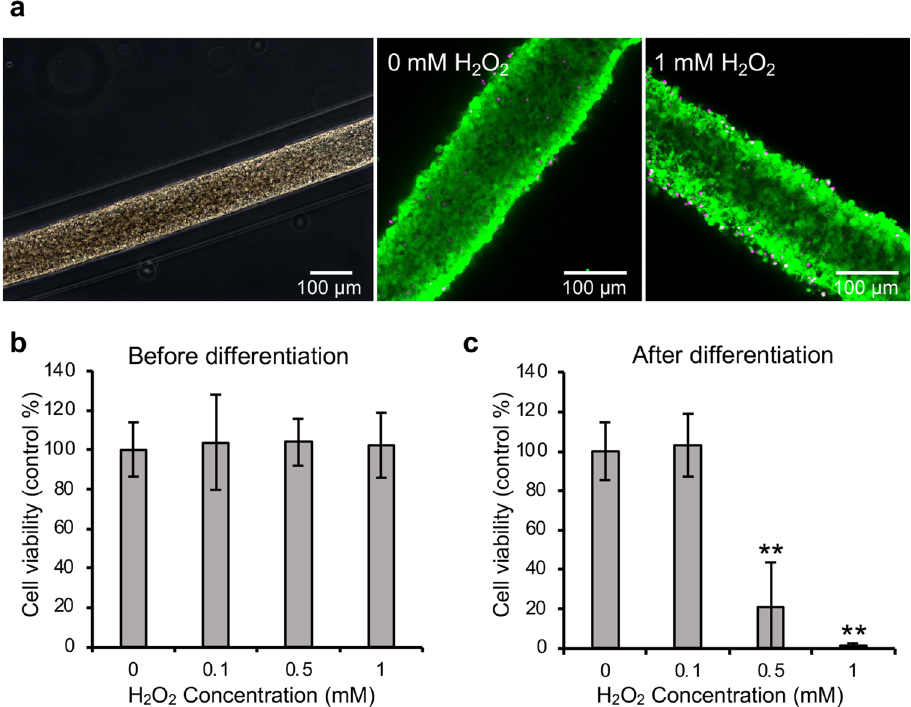
Figure 6. Cell viability of mNSC CF fragments before or after differentiation following H 2 O 2 treatment. ( a ) Phase-contrast image of mNSC CF fragment at 10 days in culture (left). Fluorescence images of live/dead assay of mNSC CF fragments treated with 0 or 1 mM H 2 O 2 for 24 h after 10 days in culture (middle and right). The live and dead cells exhibited green and magenta fluorescence, respectively. ( b ) Graph of cell viability after treatment of mNSC CF fragments at 10 days in culture with various H 2 O 2 concentrations (0–1 mM) for 24 h. ( c ) Graph of cell viability after treatment of mNSC CF fragments at 10 days in culture after differentiation with various H 2 O 2 concentrations (0–1 mM) for 24 h. The experiment was repeated three times with n = 4 (** P <